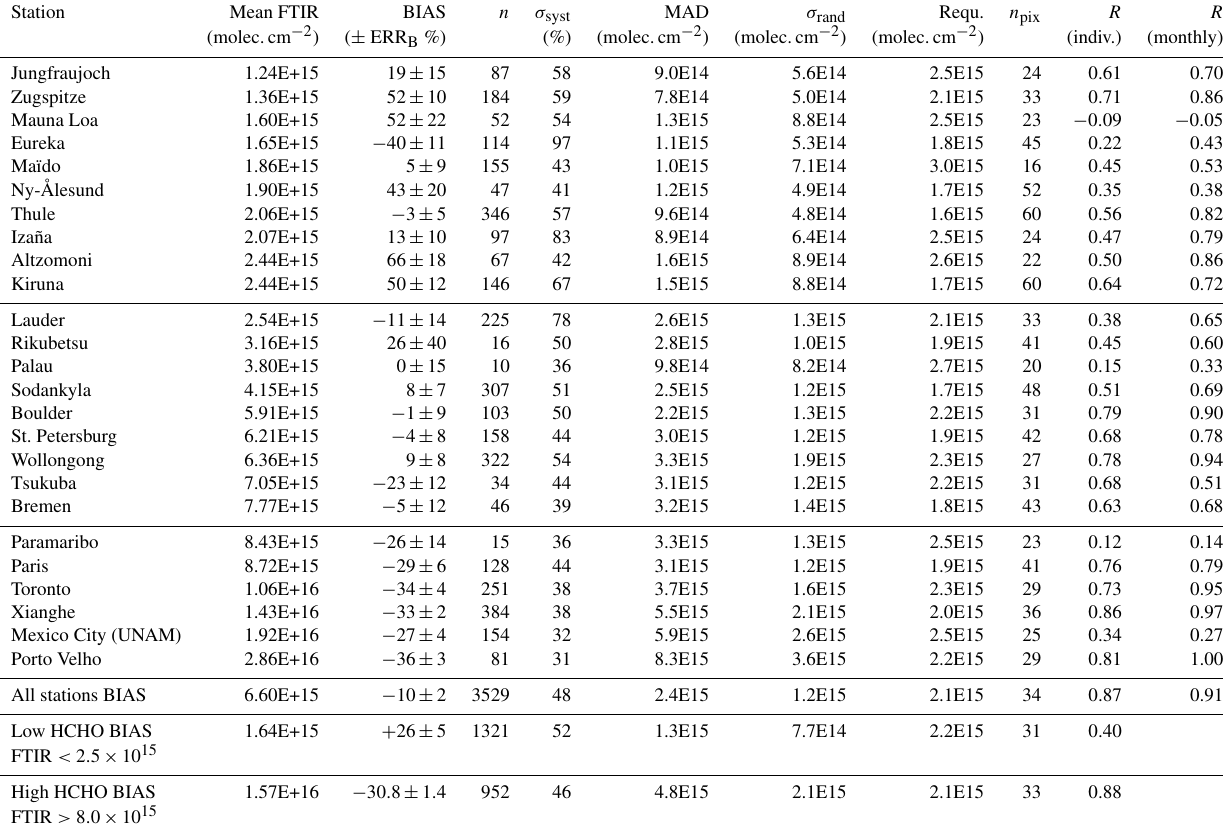
Table 3. Validation of TROPOMI RPRO + OFFL. Please note that the ordering of the sites is by increasing mean HCHO column. For each station: mean of the HCHO FTIR total columns (in molecules per square centimetre); median of the relative differences, BIAS = med ((TROP i -FTIR i )/FTIR i ) and its error ERR B (in per cent; see text); number of collocated pairs n ; systematic uncertainty in a single difference σ syst (in per cent; Eq. 6); median absolute deviation (MAD; in molecules per square centimetre; Eq. 7); random uncertainty in a single difference σ rand (in molecules per square centimetre; Eq. 8); and pre-launch TROPOMI precision requirements associated with the choice √ n pix molec.cm − 2 , with n pix being the mean number of pixels averaged in the collocated of 20km around the station Requ = 1 . 2 × 10 16 / TROPOMI data. The Pearson correlation coefficient R is given for individual coincidences ( ± 3h) and for monthly means of coincident